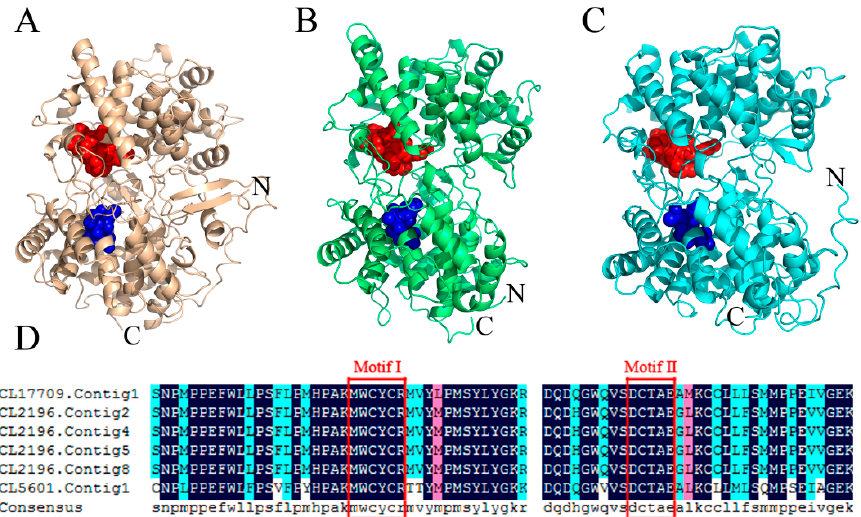
Figure 4. Spatial structure models of β -AS and the highly conserved motifs. ( A – C ) are the spatio-structural models of β -AS (CL2196.Contig2, CL5601.Contig1, and CL17709.Contig1; template: 1w6j.1.A; sequence identity: 43.10%, 39.88%, and 44.94%, respectively). The highly conserved MWCYCR (Motif I) and DCTAE (Motif II) residues are depicted as spheres in red and blue, respectively. ( D ) Alignment of β -AS amino acid sequences. Dark blue indicates identical amino acids, and red and lightskyblue indicate similar amino acids. Multiple sequence alignment was performed using the DNAMAN 6.0.3.99 software.